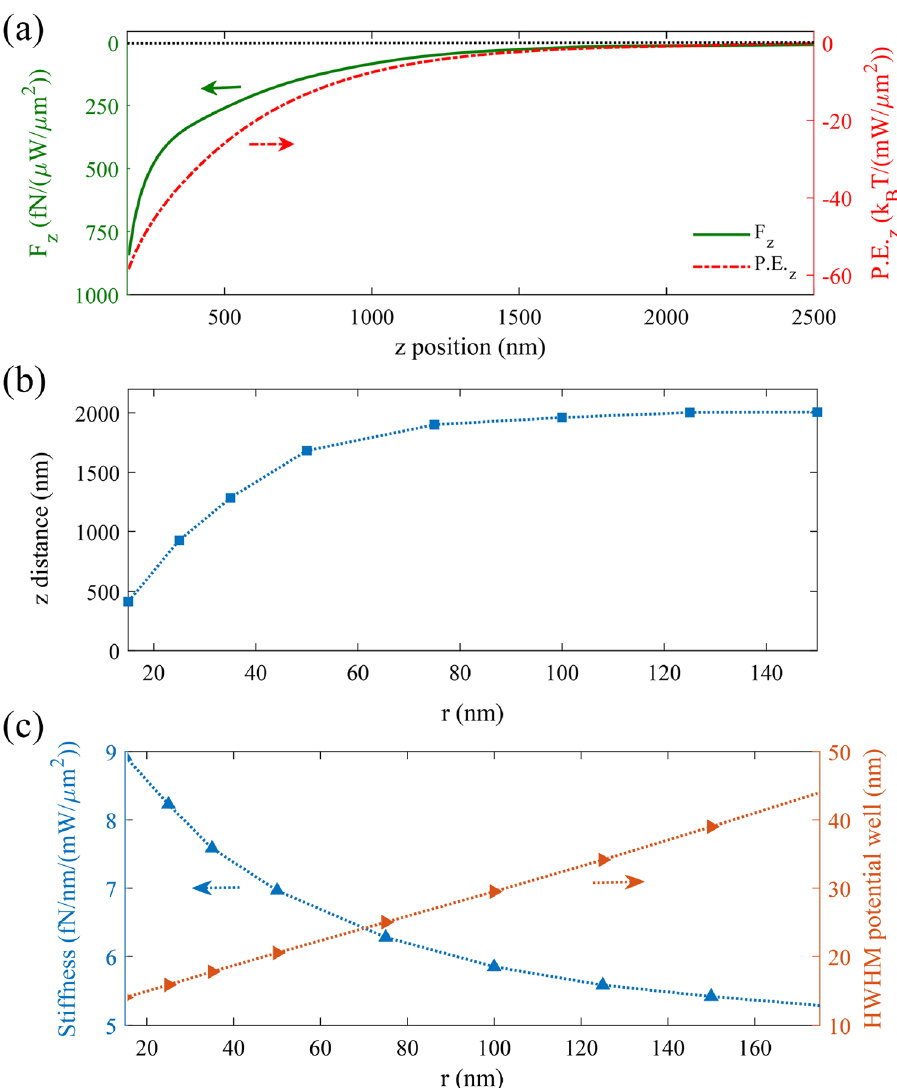
Figure 7. ( a ) The left and right axes show the z component of the LSPM force and the resulting potential, versus the z position of the particle with r = 100 nm, at the x – y position wherein the potential energy is minimized ( x = 0, y = 145 nm). ( b ) Variation of the LSPM trapping height, wherein P.E. z equals 10 k B T , versus varying the particle radius. The incident power has been assumed 50 mW μm −2 . ( c ) DSPM related trapping stiffness along y direction ( s y ) (blue curve), and HWHM (red curve) versus the radius of the